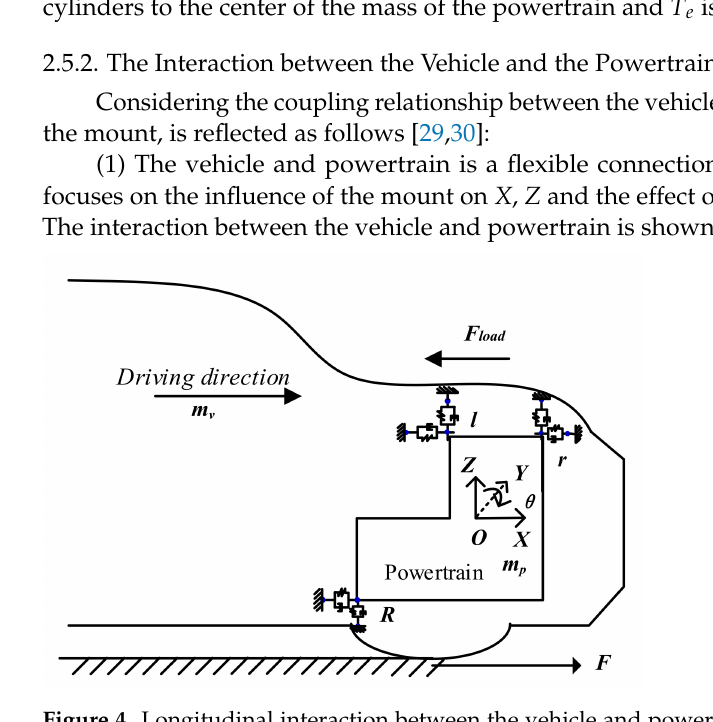
Figure 4. Longitudinal interaction between the vehicle and powertrain, where m p and m v are the mass of the powertrain and the vehicle excluding the powertrain; F mou is the force of the mount; F load is the resistance of vehicle and F is the driving